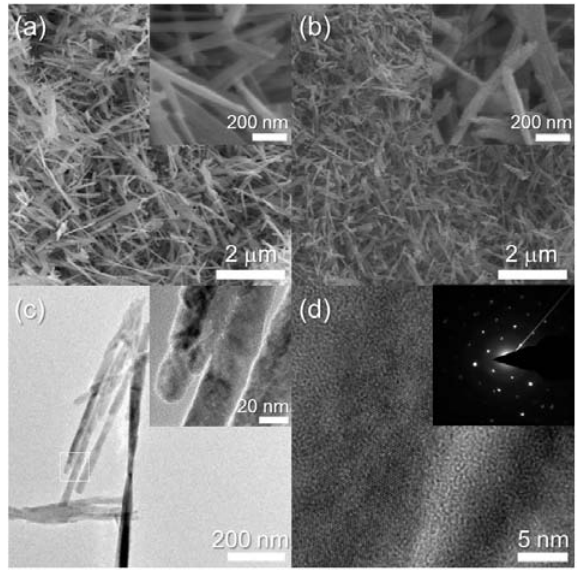
Figure 4. SEM and TEM images of 2.2Cr-CuO nanorods. ( a ) SEM image of as-prepared 2.2Cr-CuO nanorods, ( b ) SEM image of 2.2Cr-CuO nanorods after heat treatment at 500 °C for 1 h , and ( c , d ) TEM images and SAED pattern of 2.2Cr-CuO nanorods after heat treatment at 500 °C for 1 h